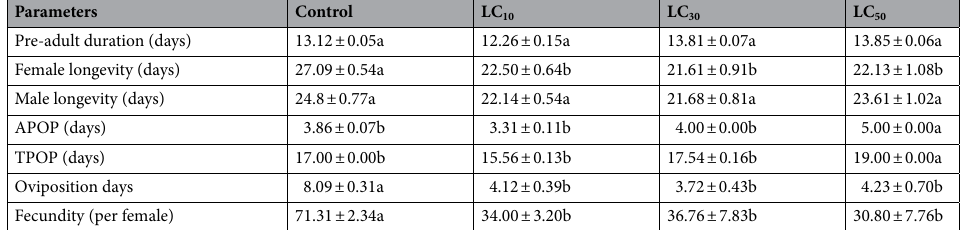
Table 2. Transgenerational effect of Lambda-cyhalothrin on different life table parameters of Musca domestica. TPOP total pre-oviposition period of female counted from birth, TPOP total pre-oviposition period of female counted from birth. Means in the same row followed by the same letter are not significantly different ( P > 0.05) using bootstrap test.